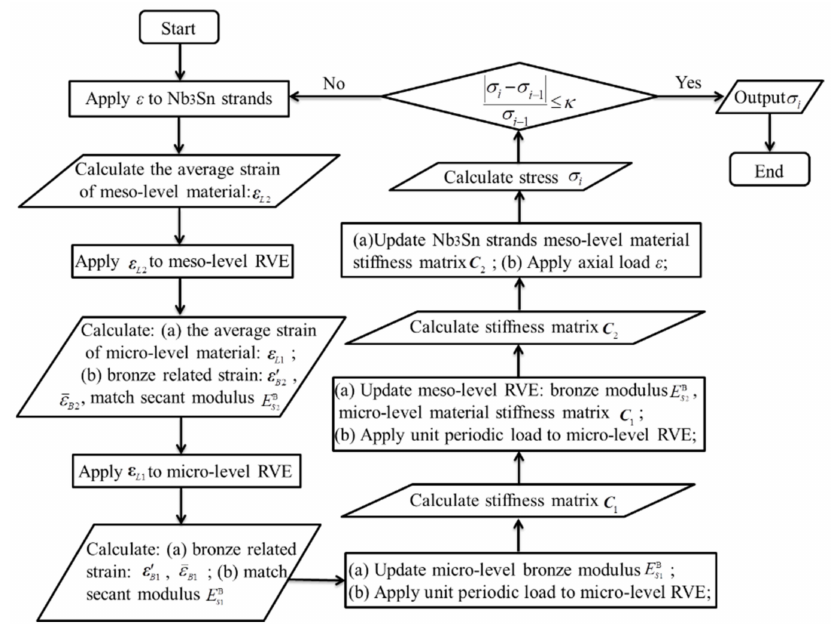
Figure 6. Flow chart of meso-mechanical homogenization algorithm considering matrix plasticity ( κ represents